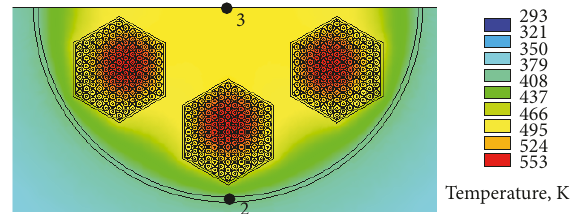
Figure 4: Temperature field of the cask.